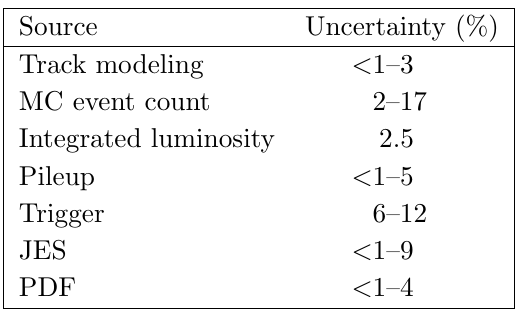
Table 5 . Ranges of systematic uncertainties over all models given in table 1 for which a 95% CL exclusion is expected, for the uncertainties from di(cid:11)erent